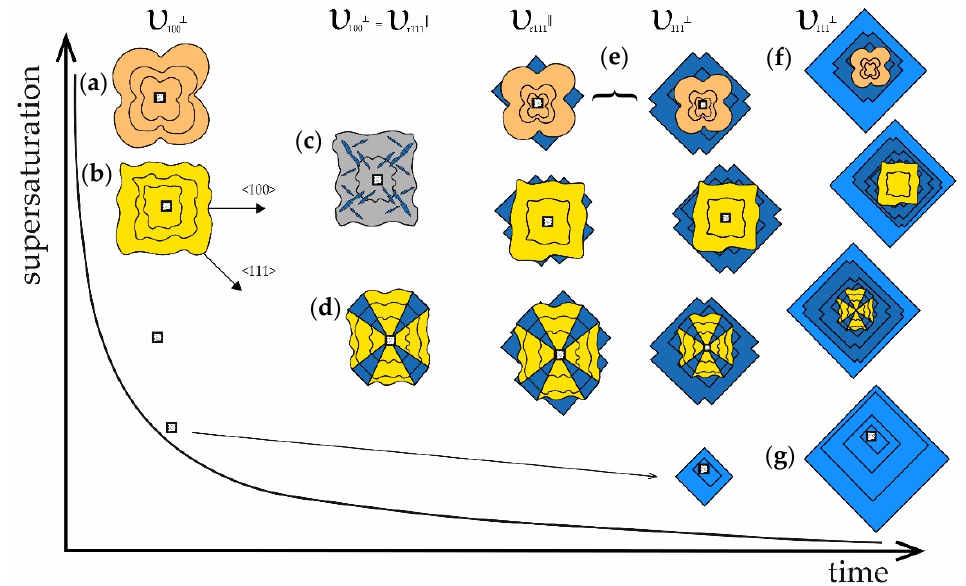
Figure 9. Scheme of evolution of diamond crystal morphology and internal structure in one crystallogenesis cycle (upgraded from [10]) due to a change in the dominant growth mechanism: ( a ) normal mechanism, concentric zoning; ( b ) normal mechanism, wavy zoning; ( c ) (111) growth of lamellar cubic crystals; ( d ) simultaneous growth by normal and tangential mechanisms; ( e ) change of crystal habit during regeneration growth; ( f , g ) tangential growth. The nucleation of crystals is possible only at the stages ( a , b ). The images are arranged according to the black graph line. The components of the growth rate that determine the crystal shape are shown.